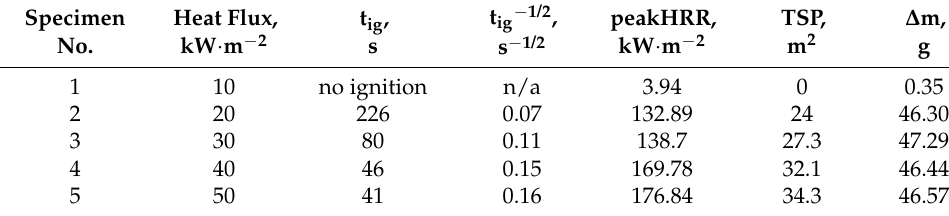
Table 4. Cone calorimeter results for coaxial power PVC-based cable (specimen 4).